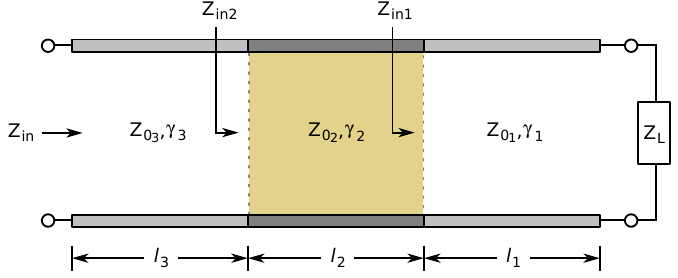
Figure 4. Approach to calculating the input impedance of a transmission line with multiple sections of different characteristic